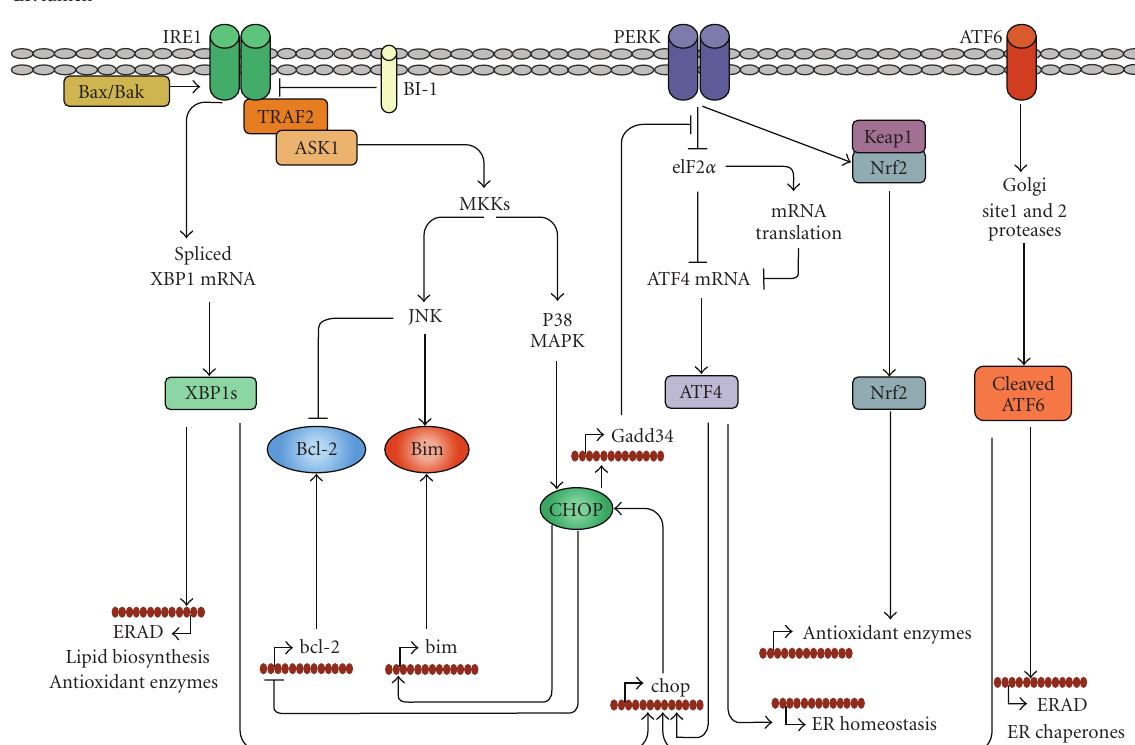
Figure 1: The unfolded protein response in adaptive, apoptotic and redox responses. Upon accumulation of misfolded proteins in the ER, the release of BiP allows IRE1 and PERK to oligomerize. Oligomerized IRE1 disposes of an intrinsic endoribonuclease activity that mediates the unconventional splicing of XBP1mRNA which is subsequently translated into XBP1s, a potent transcription factor regulating expression of genes involved in ERAD and ER quality control. IRE1 signaling is positively regulated by binding of the multidomain proapoptotics Bax and Bak, while its activity is suppressed by the transmembrane protein BI-1. The interaction of Bax/Bak with IRE1 is required for the recruitment of TRAF2 and ASK1 leading to the activation of the MAPKs JNK and p38 MAPK, through specific MKKs. Oligomerized PERK phosphorylates the translation initiating factor eIF2 α , resulting in suppression of general protein translation while favoring the translation ATF4, which induces the expression of genes involved in restoring ER homeostasis. Phosphorylation of Nrf2 by PERK disrupts its association with Keap1 resulting in its nuclear accumulation and upregulation of genes associated with various antioxidant responses. In contrast to PERK and IRE1, release of BiP from ATF6 induces its translocation to the Golgi where its processing generates an active transcription factor. Cleaved ATF6 controls mainly genes involved in ERAD and ER homeostasis. Upon severe ER stress, ATF4, XBP1s, and ATF6 can upregulate the expression of the proapoptotic transcription factor CHOP, which mediates apoptosis by the upregulation of proapoptotic BH3-only protein Bim and by suppressing Bcl-2 expression. CHOP activity is enhanced through phosphorylation by p38MAPK. Phosphorylation by JNK in turn activates Bim while inhibiting Bcl-2